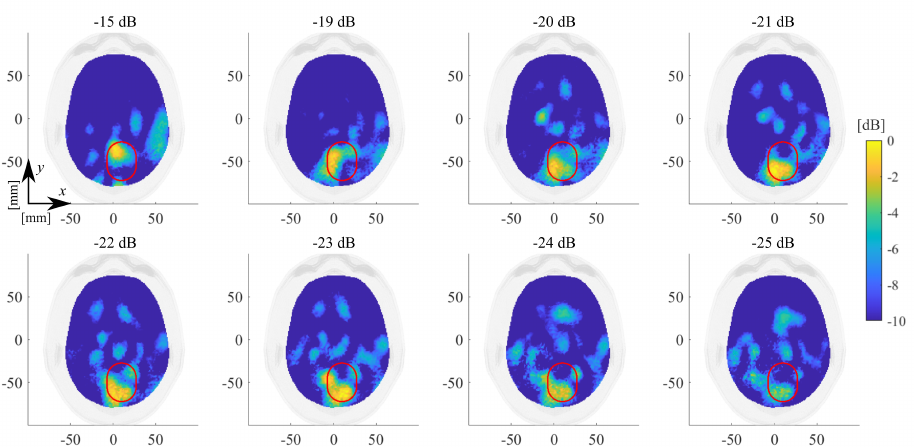
Figure 9. ICH-MTP_1 amplitude values of the normalized reconstructed dielectric contrast in the transverse plane view varying the threshold on the singular values between − 15 and − 25dB. The expected stroke area is indicated with a red